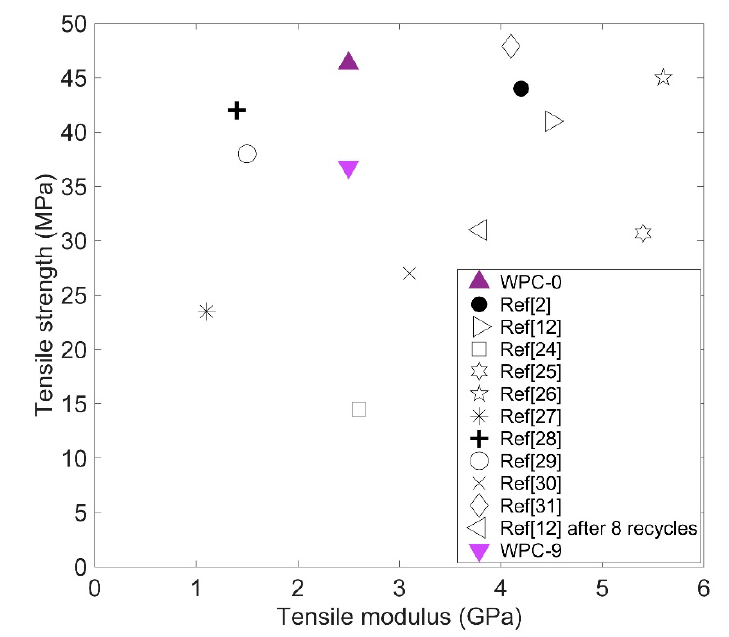
Figure 10. Comparative tensile strength versus modulus for different WPCs in the literature.